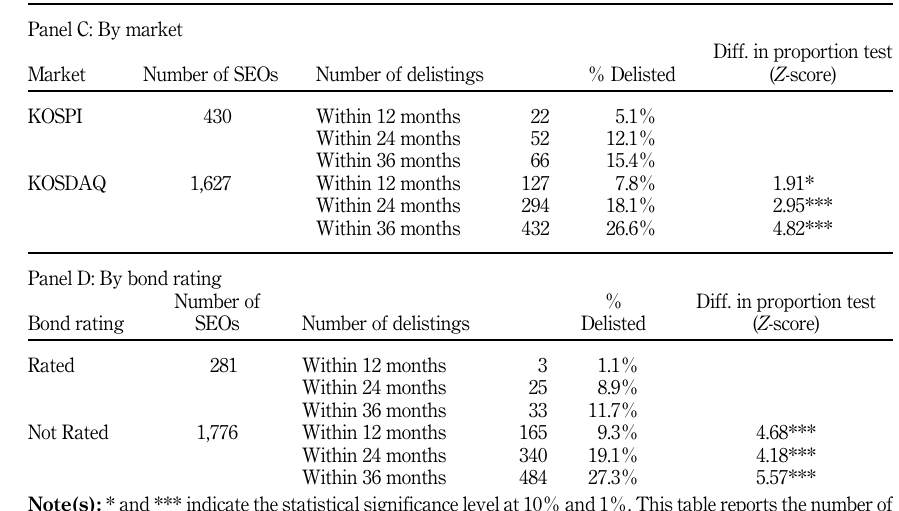
by SEO type and